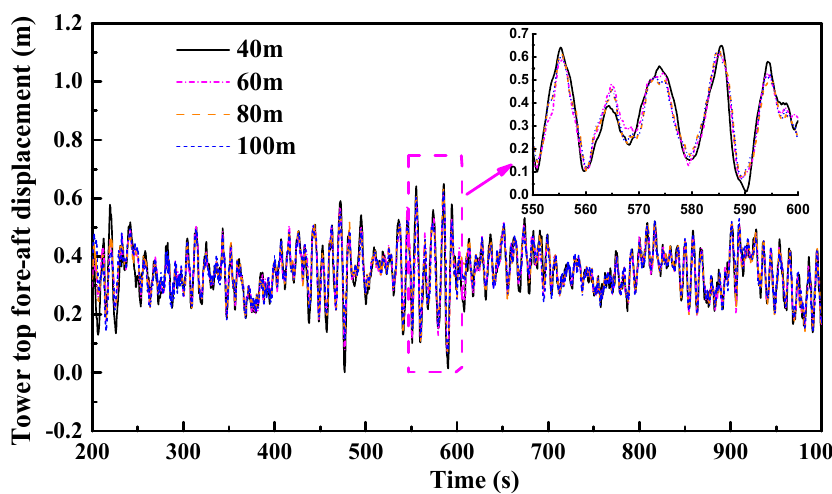
Figure 7. Time series of tower top fore-aft displacements for different tether lengths.